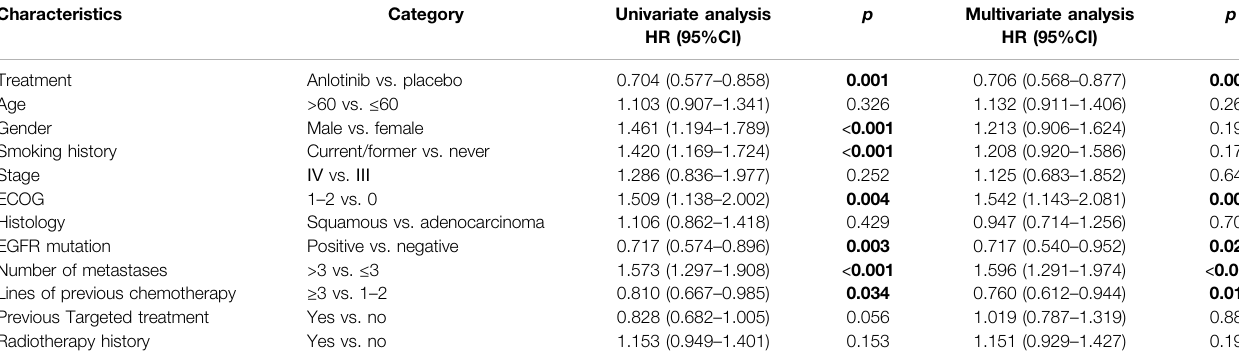
TABLE 2 | Univariate and multivariable analyses for variables associated with OS in non-obesity ( n = 505).